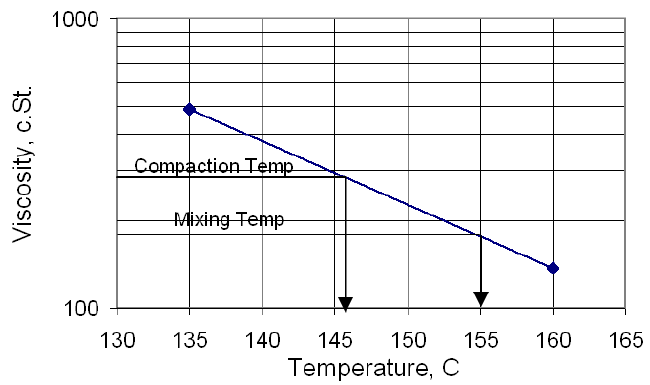
Figure 5. Viscosity – temperature chart of PG 64-16. Figure 5. Viscosity–temperature chart of PG